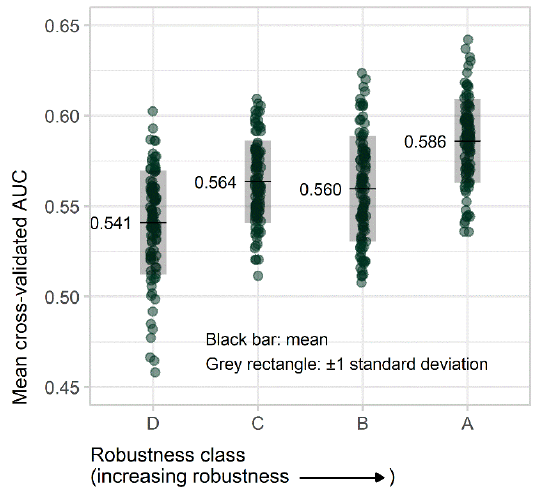
Figure 7. Mean five-fold cross-validated AUC results obtained with resampling techniques. There is an overall trend of higher AUC going from class D (least robust features) to A (most robust features). This demonstrates that more robust features offer superior case-control classification performance in risk-assessment Table 2. Characteristics of participants in independent data set used to test the performance of radiomic features in case- control regression. Characteristic Total Population: 575 Women